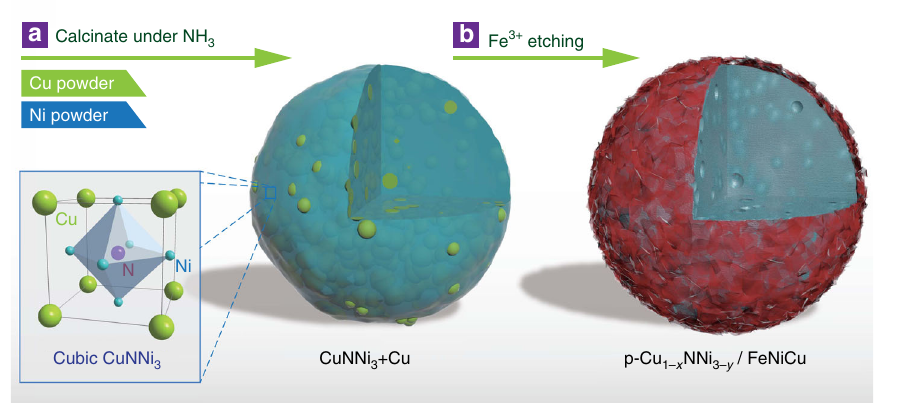
Fig. 1 Illustration of the synthesis of p-Cu 1 − x NNi 3 − y /FeNiCu. a Synthesis of CuNNi 3 + Cu through solid-gas reactions. b Formation of p-Cu 1 − x NNi 3 − y /FeNiCu after the Fe 3 +